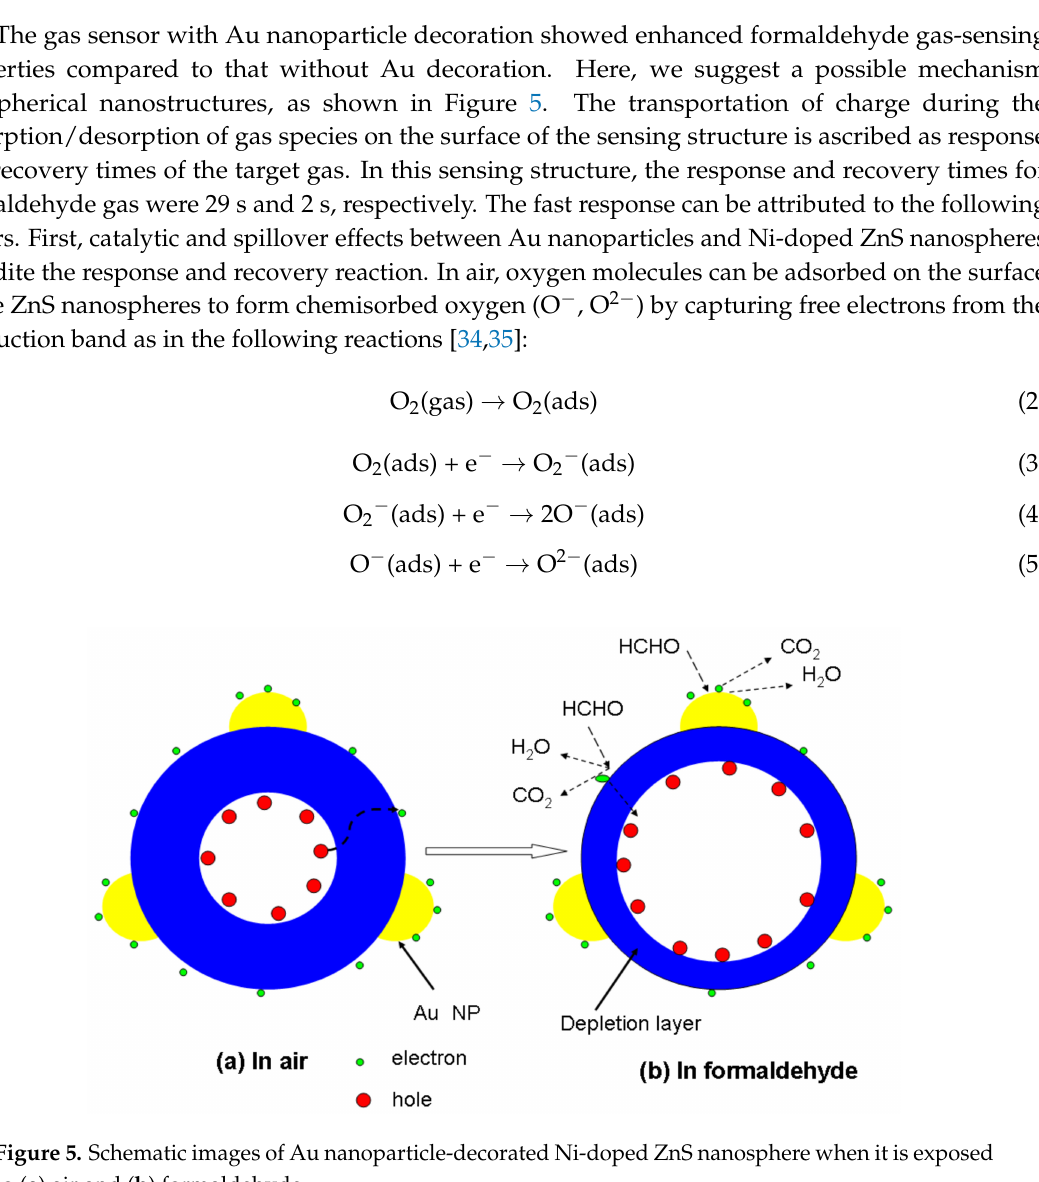
Figure 5. Schematic images of Au nanoparticle-decorated Ni-doped ZnS nanosphere when it is exposed to ( a ) air and ( b )